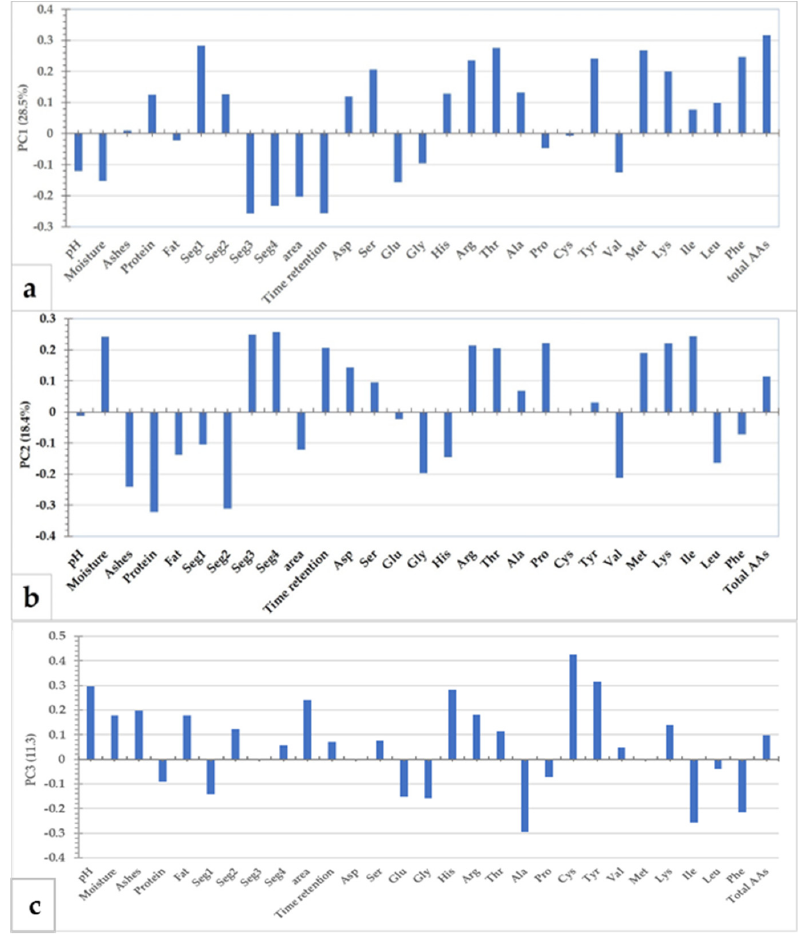
Figure 6. ( a ) Graph of the loadings of PC1, ( b ) graph of the loadings of PC2, and ( c ) graph of